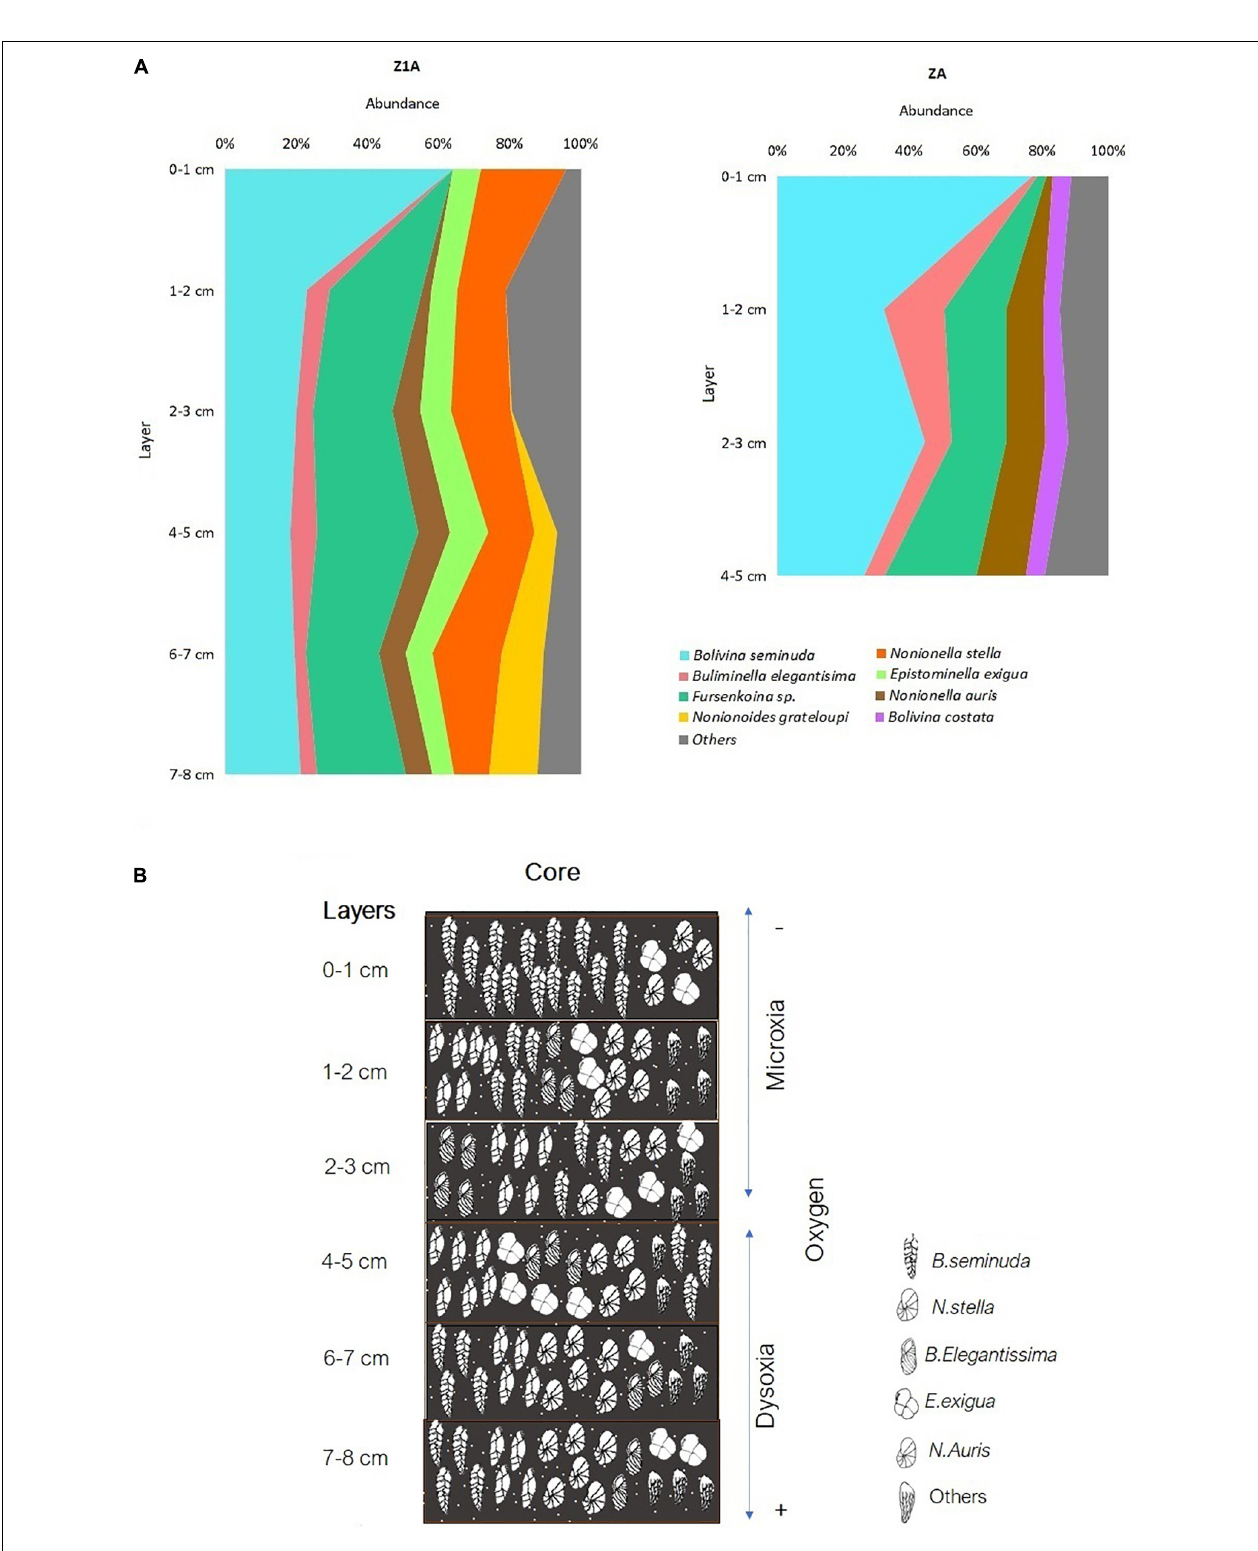
FIGURE 10 | (A) Abundance (%) of the predominant benthic foraminifera species in cores Z1A and ZA. (B) General vertical distribution of benthic foraminifera in core Z1A.